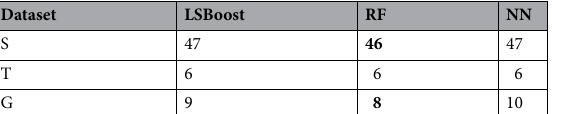
Table 1. Results of regression models LSBoost, RF, and NN. The performances of the models were evaluated in terms of RMSE trained on striped dolphin S, common bottlenose dolphin T, and Risso’s dolphin G datasets using five runs of the cross-validation procedure. Bold characters indicate the best performance among all the models.